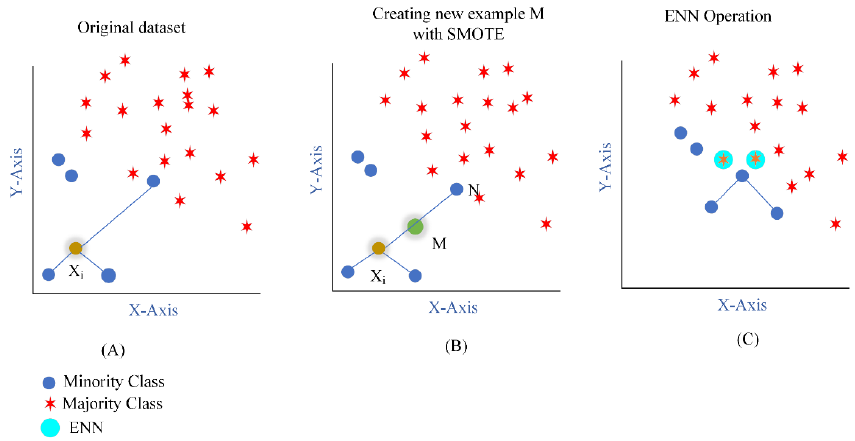
Figure 3. Illustration of SMOTE-ENN with a toy example [39]. ( A ) represent the dataset before applying SMOTE-ENN. ( B ) represent the SMOTE operation where new examples for minority class are generated and ( C ) represent the ENN operation in which unnecessary examples are removed.